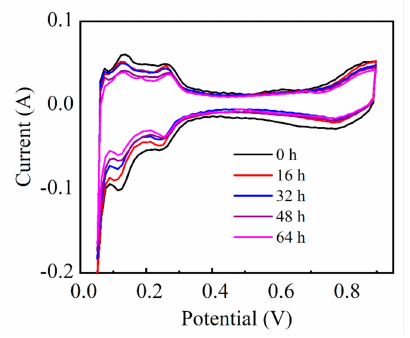
Figure 5. CV curves profiled during the 64 h durability testing.